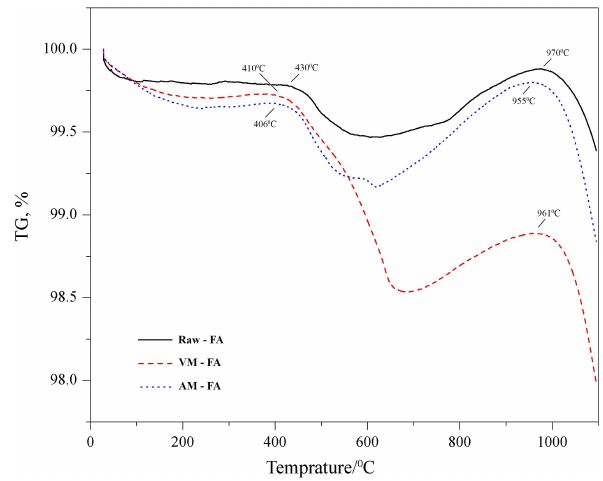
Figure 3: TG of the raw and milled fly ashes.